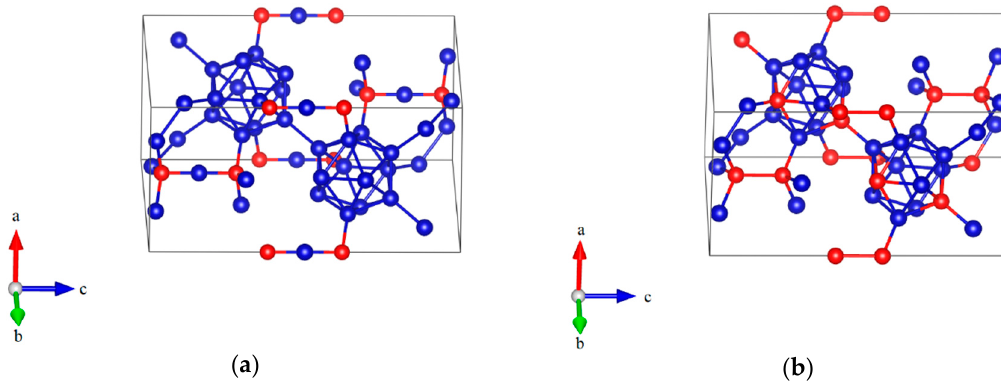
Figure 1. The atomic structures of boron- and carbon-rich boron carbide with hexagonal lattice: ( a ) B 12 –CBC configuration; ( b ) B 10 C 2P –CC configuration (Blue = B atoms; red = C atoms).